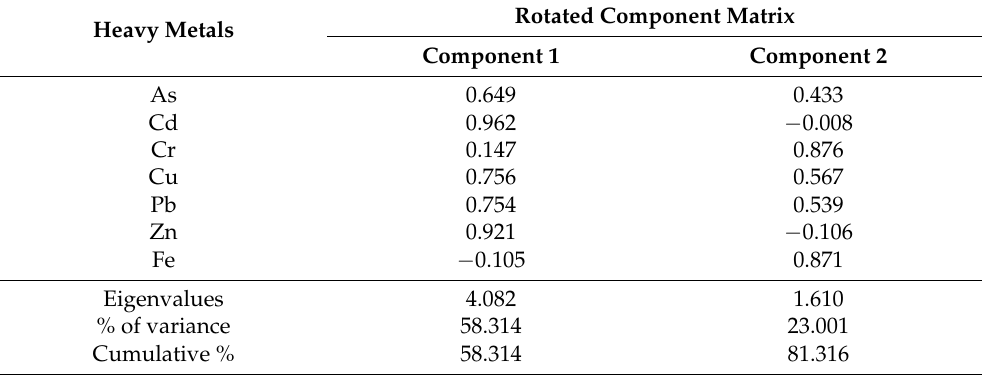
Table 2. Principal component analysis (PCA) of heavy metals in Manwan (M) and Dachaoshan (D) cascading